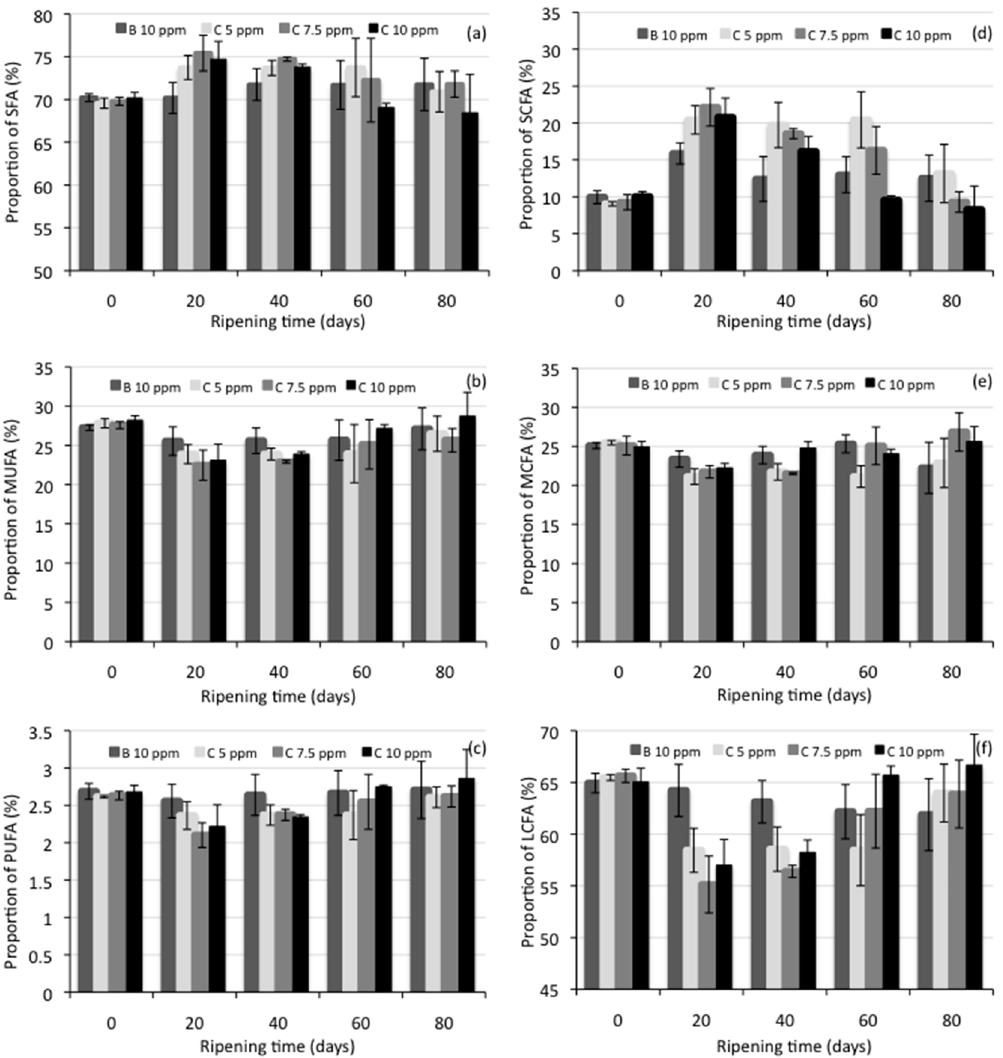
Figure 1. Proportion of fatty acid groups in Manchego-style cheeses at different ripening times; ( a ) saturated (SFA), ( b ) mono-unsaturated (MUFA), ( c ) polyunsaturated (PUFA), ( d ) short-chain (SCFA), ( e ) medium-chain (MCFA), and ( f ) long-chain (LCFA) fatty acids. SCFA = C4-C8; MCFA = C10–C15; LCFA = C16–C18. B = bixin, C = curcumin.